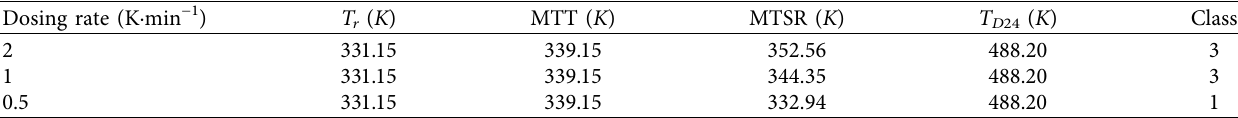
Table 5: Stoessel criticality diagram for synthesis of Grignard reagent at different dosing rates.